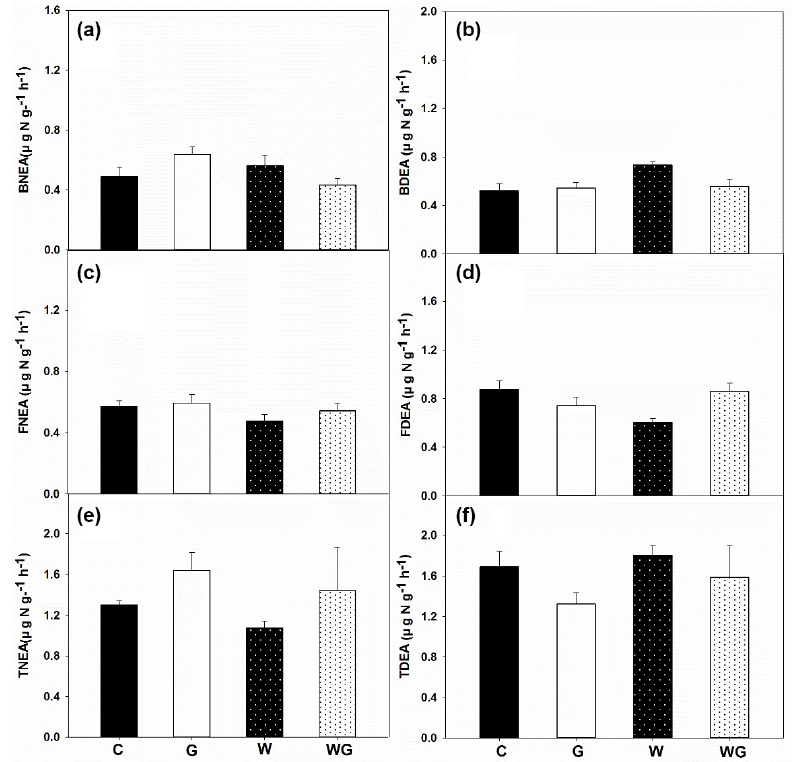
Figure 4. Bacterial nitrification enzyme activity (BNEA) (a) , fungal nitrification enzyme activity (FNEA) (b) , total nitrification enzyme activity (TNEA) (c) ; bacterial potential of N 2 O production from denitrification (BDEA) (d) , fungal potential of N 2 O production from denitrification (FDEA) (e) and total potential of N 2 O production from denitrification (TDEA) (f) in an alpine meadow. C (black bar), control treatment; G (white bar), winter grazing treatment; W (white-dotted bar), warming treatment; WG (black-dotted bar), warming combined with the winter grazing treatment. Values are means ± 1s.e.m. ( n =